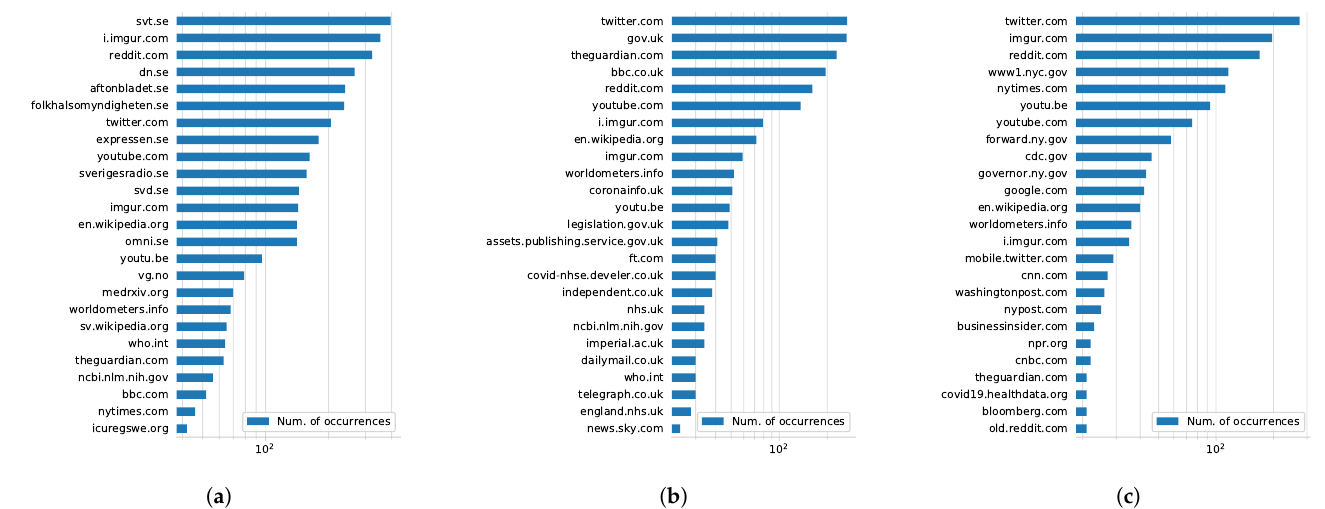
Figure 12. The top 25 most linked web domains in ( a ) /r/sweden, ( b ) /r/unitedkingdom and ( c )